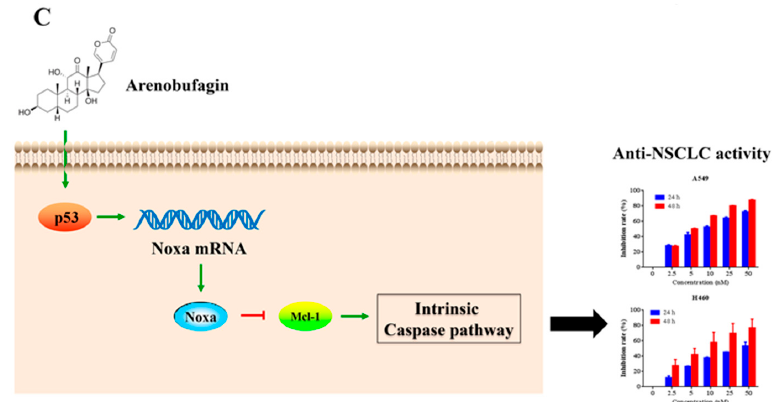
Figure 5. p53’s role in arenobufagin-induced Noxa upregulation. ( A ) Reverse-Transcription PCR (RT-PCR) analysis of the expression of Noxa at the mRNA level in NCI-H460 cells treated with arenobufagin (25 nM) for indicated time points; ( B ) Western blot analysis of the protein expression of p53, c-Myc, and E2F1 in NCI-H460 cells treated with arenobufagin (25 nM) for indicated time points; ( C ) The schematic model of the molecular mechanisms of anti-NSCLC activity of arenobufagin. * p < 0.05 compared with the control group; ** p < 0.01 compared with the control group; *** p < 0.001 compared with the control group.